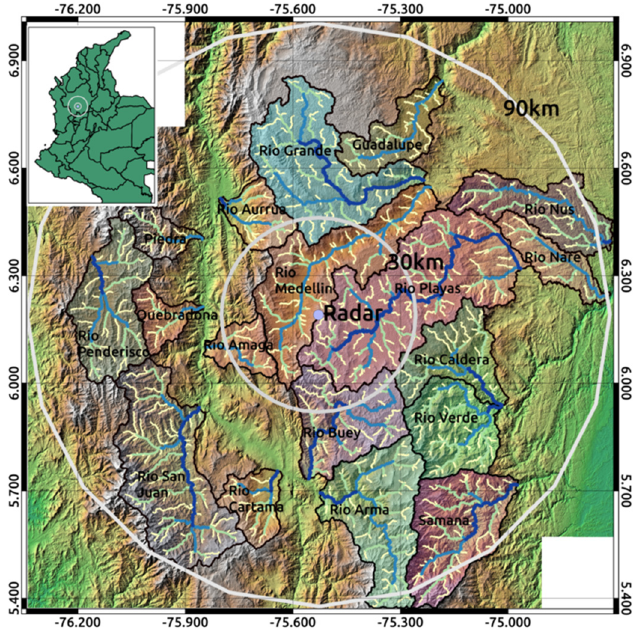
Figure 1. Region of analysis, radar localization is presented at the center of the image, and gray circles correspond to radar radii of 30 and 90 km, respectively. Yellow to dark blue colors represents the stream network Horton orders from 3 to